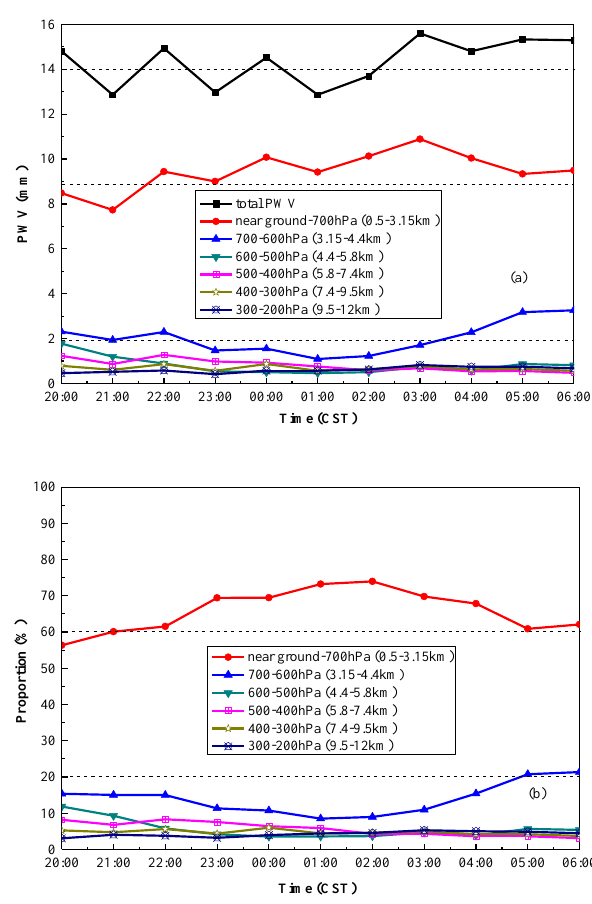
Figure 5. Temporal and spatial variations in PWV; ( a ) PWV in each layer; ( b ) its proportion in each layer.